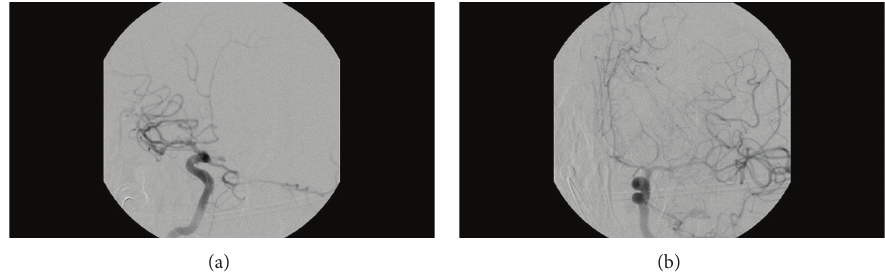
Figure 5: Formal cerebral angiogram performed on postoperative day 5. (a) Right ICA injection demonstrating vasospasm in the right ACA and the right frontal M2 branch with no flow restriction. (b) Left ICA injection showing vasospasm in the left